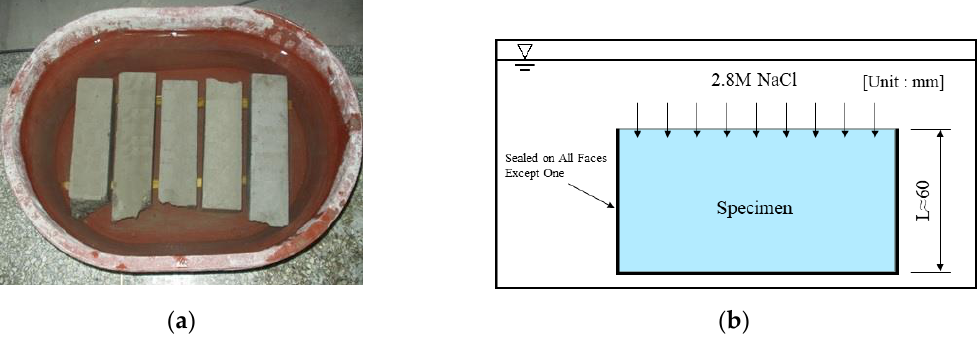
Figure 4. Test method of chloride penetration depth. ( a )experimental setup of specimens; ( b ) test method.